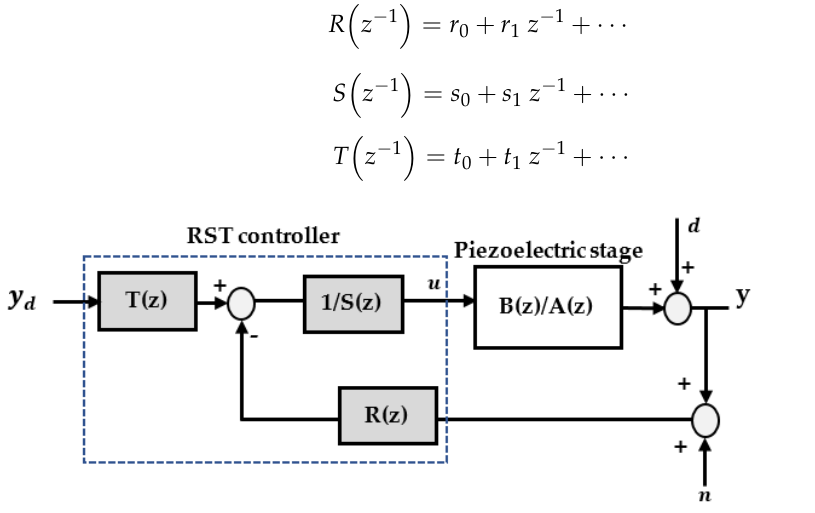
Figure 9. Structure of the RST controller.